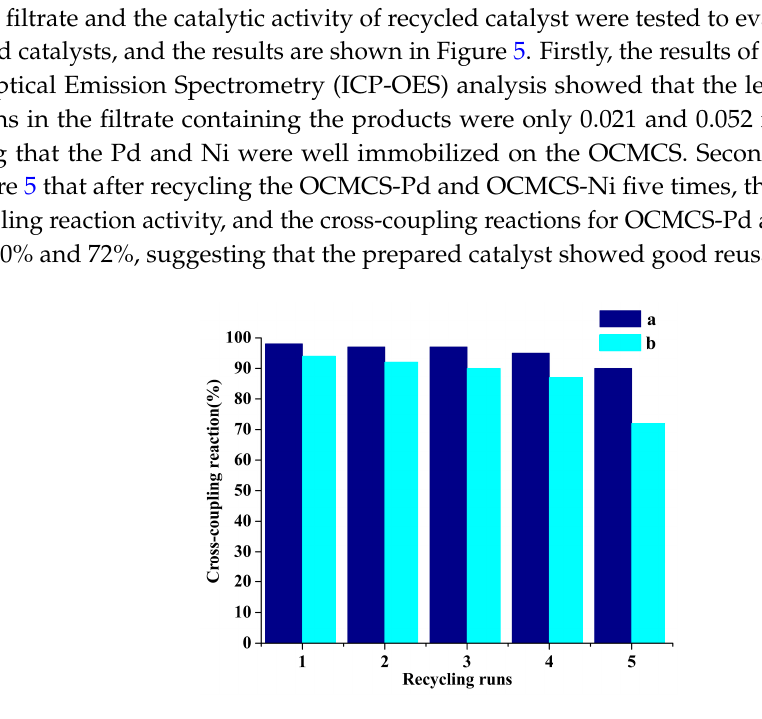
Figure 5. Dependence of the cross-coupling yield on the recycling run with the recovered ( a ) OCMCS-Pd and ( b ) OCMCS-Ni